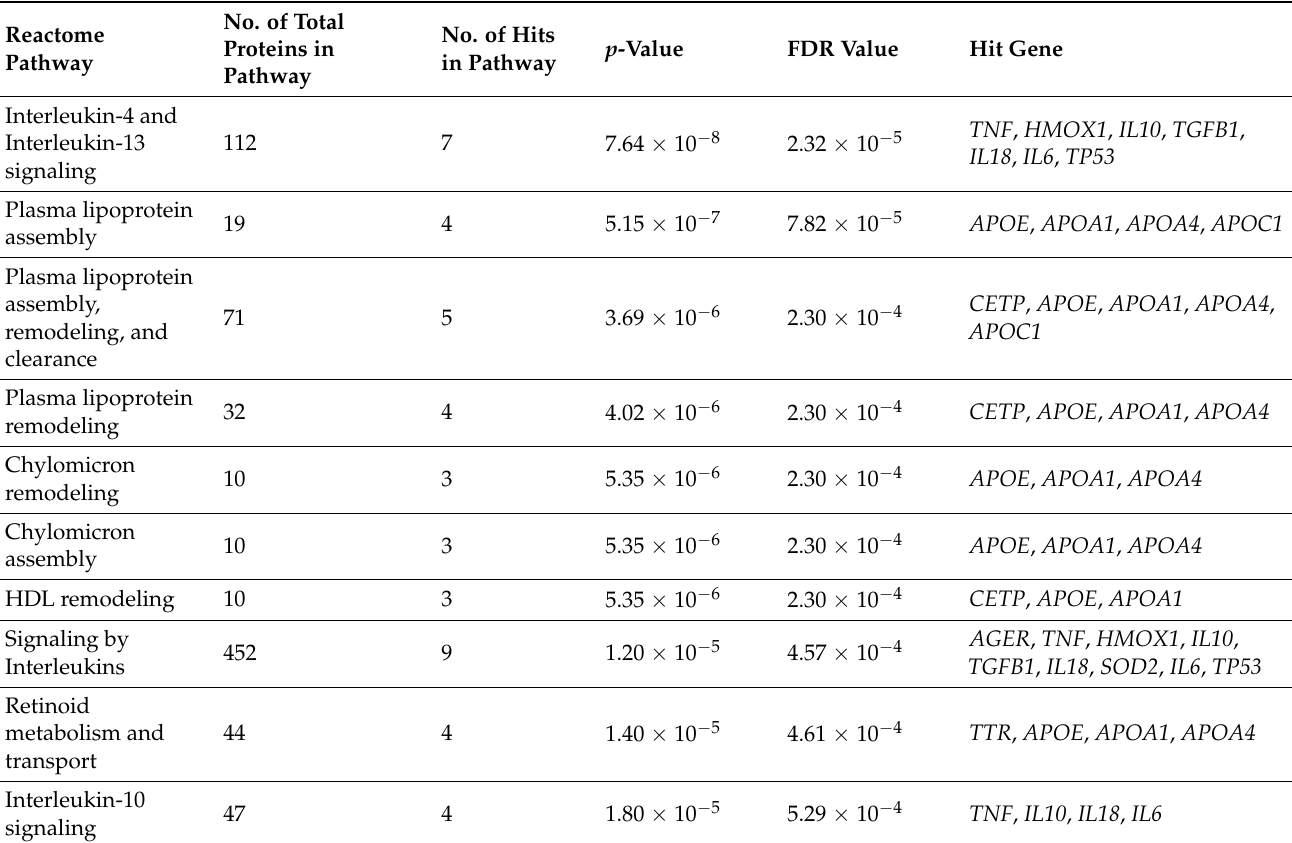
Table 7. Reactome pathway enrichment analysis results—longevity and AD overlap